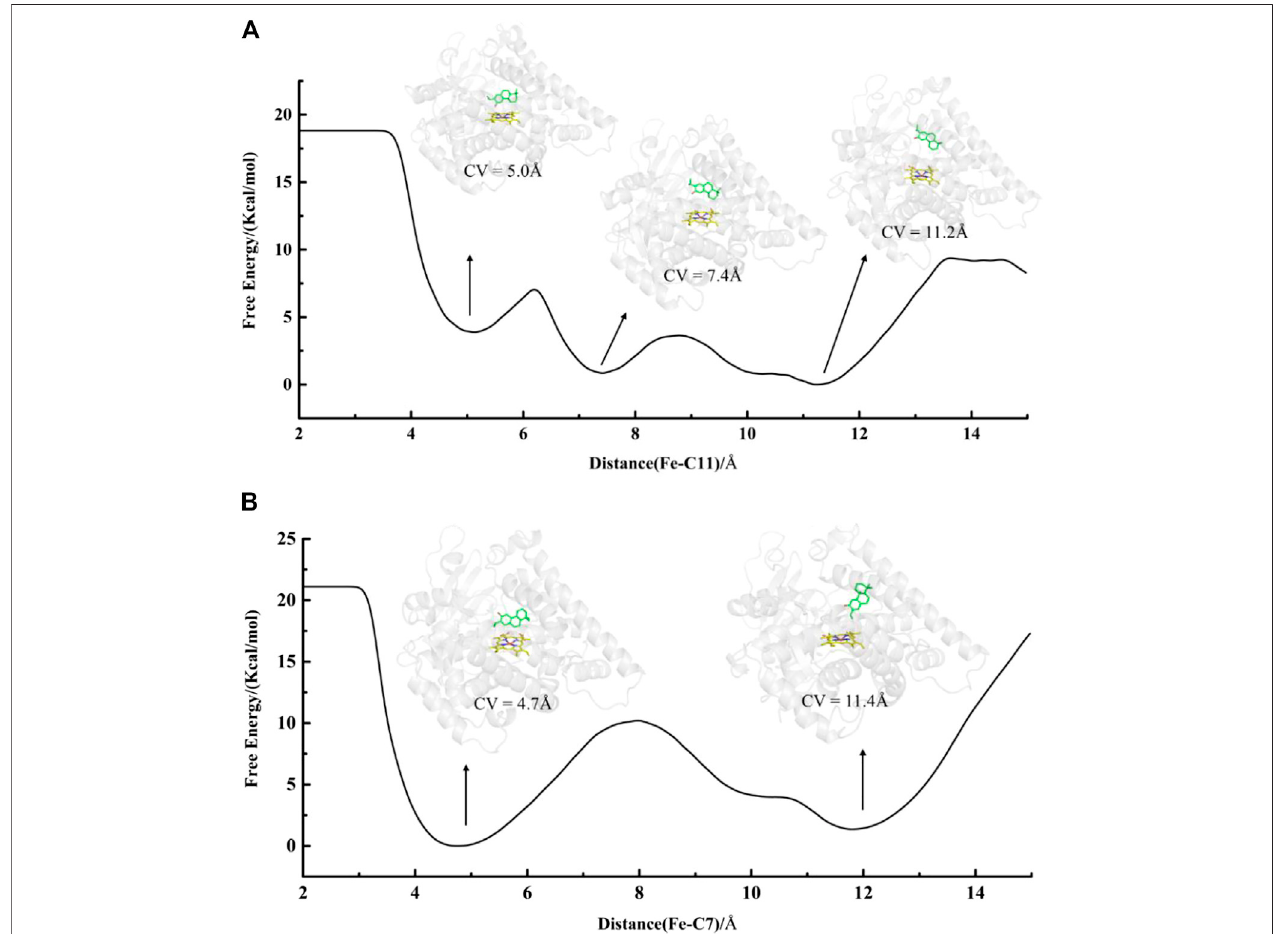
FIGURE6| Freeenergypro fi lesofbindingposestransformationforsystems (A) mut-fer-C11-Rest and (B) mut-fer-C7-Rest.ThedistanceofFe-C7and Fe-C11is de fi ned as CVs which range from 2 to 15 Å.